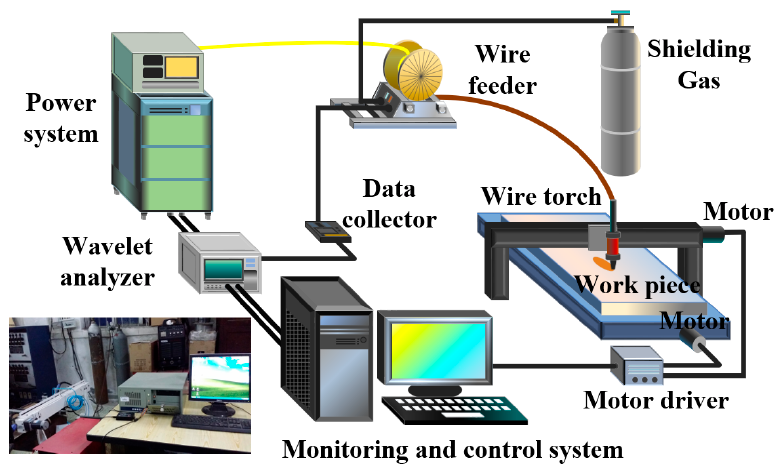
Figure 3. The welding system of DP-GMAW.